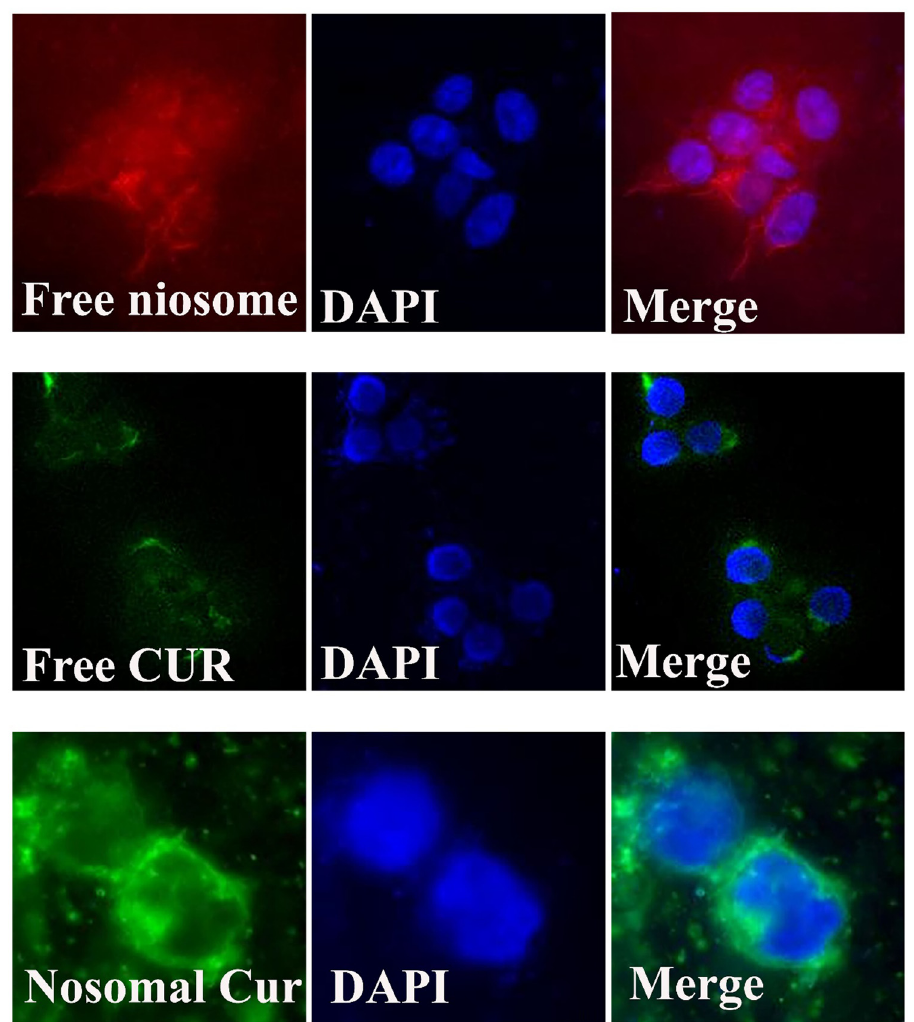
Figure 9: Cellular uptake images of A270s incubated with the modi fi ed niosomal NPs for 4